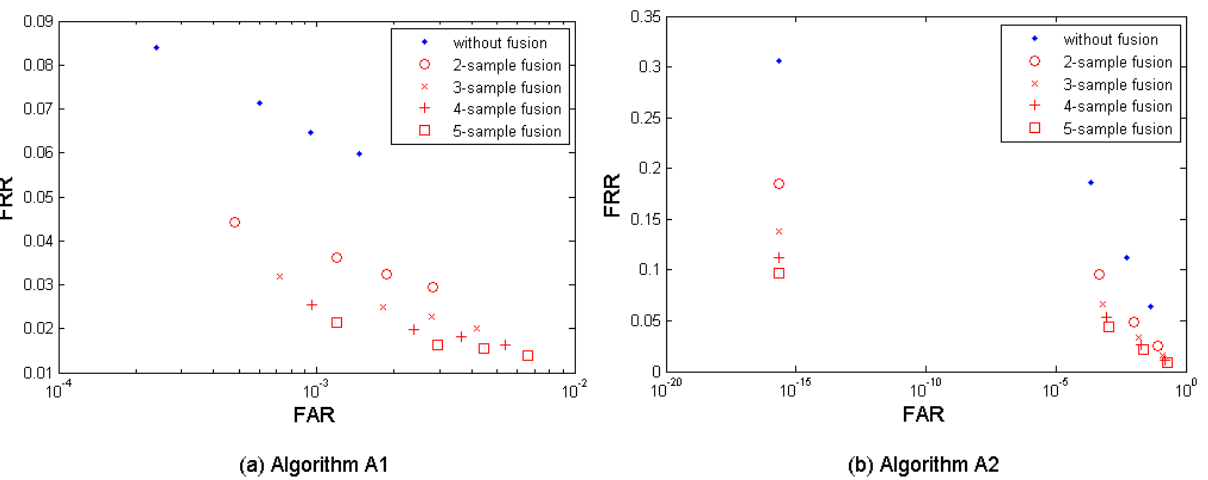
Figure 3. Multi-sample fusion results from the three anonymized biometric template protection algorithms A1, A2, and A3 developed in project